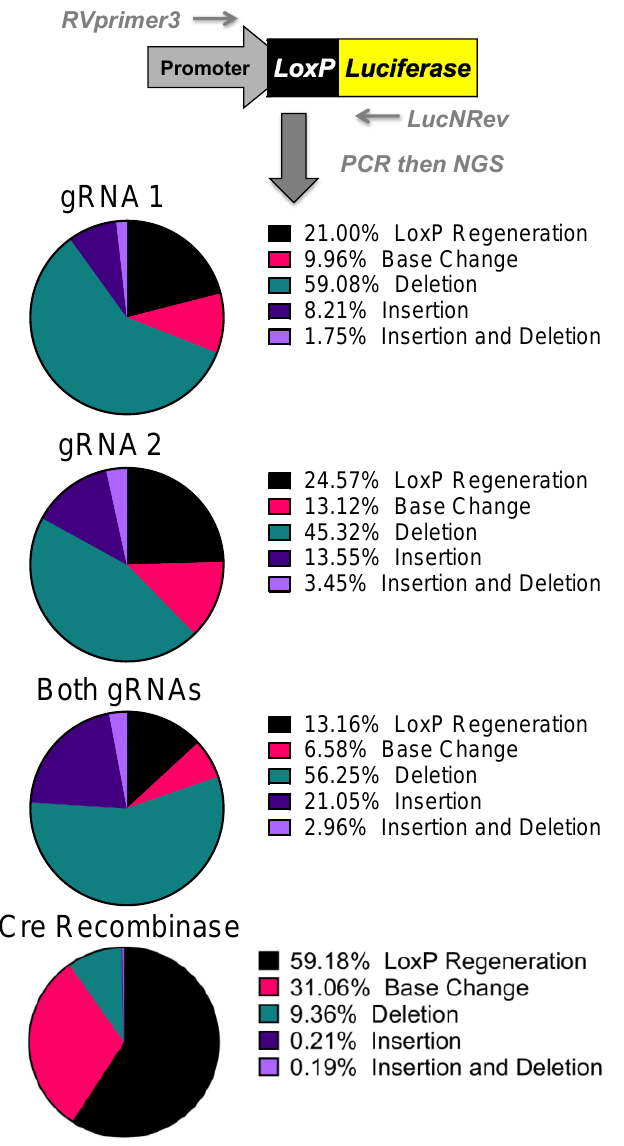
Figure 3. Sequencing of Repair Juncture. DNA was harvested from the previous transfections and amplified using primers in the SV40 promoter and luciferase with next generation sequencing (NGS) sequencing adapters. Using Amplicon-EZ through Genewiz, the deletion results were analyzed and quantified (n = 1).